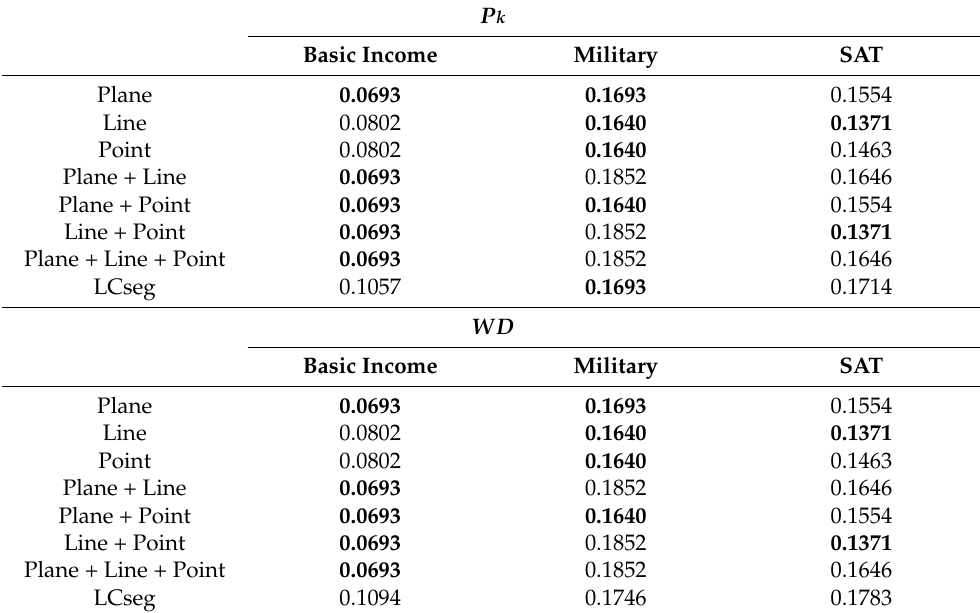
Table 4. CSseg P k and WD values with the weight of other-continuity set to 2.